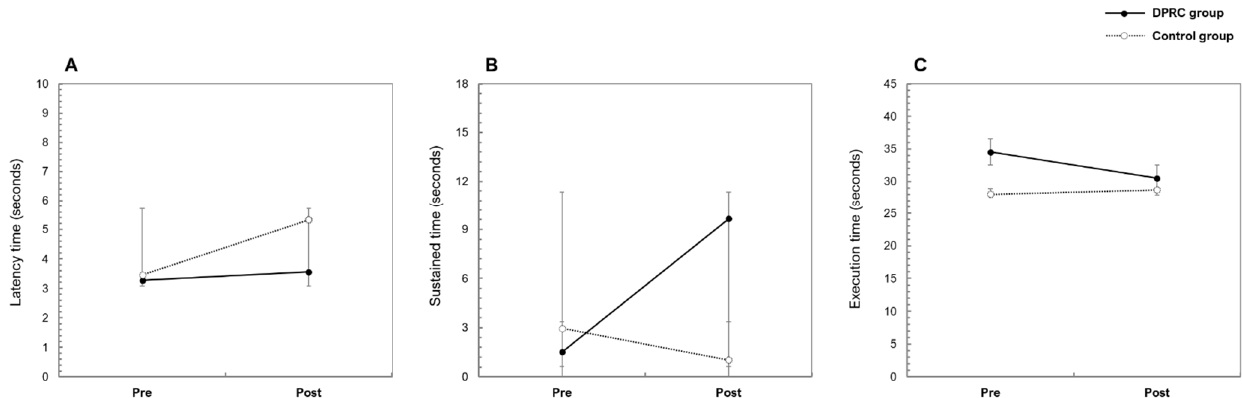
Figure 3. Changes in motor control measures for the DPRC and control groups. Panel ( A ) shows change in latency time until entrainment for 105 BPM, panel ( B ) shows change in sustained time of entrainment for 45 BPM, and panel ( C ) shows change in execution time of left hand for NHPT.